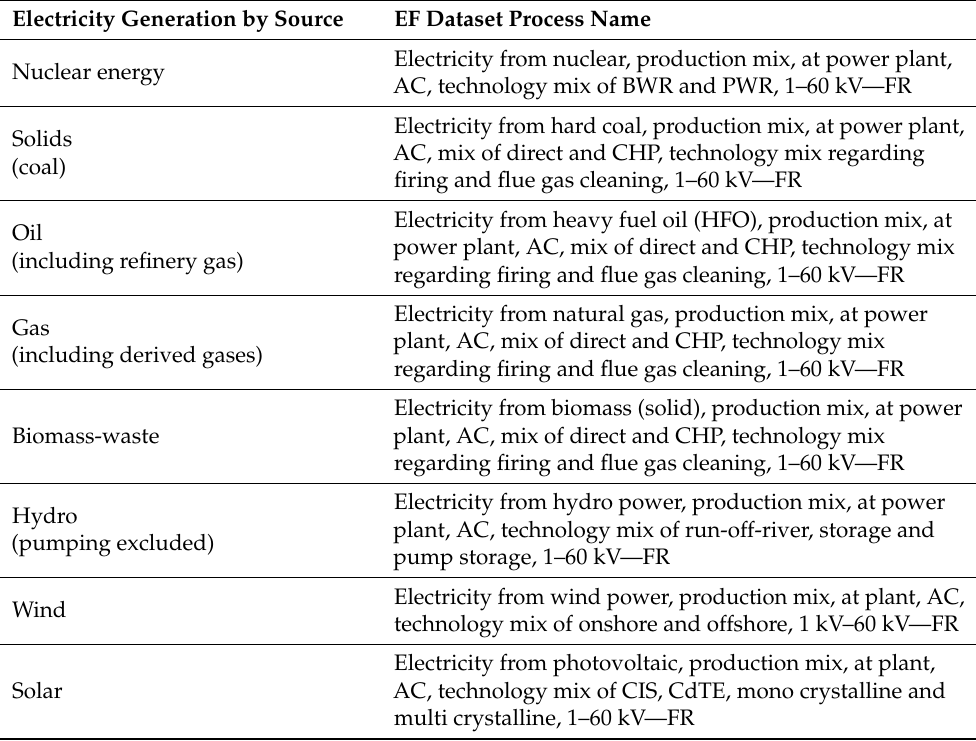
Table 2. Processes used for each energy source as retrieved from the EF2